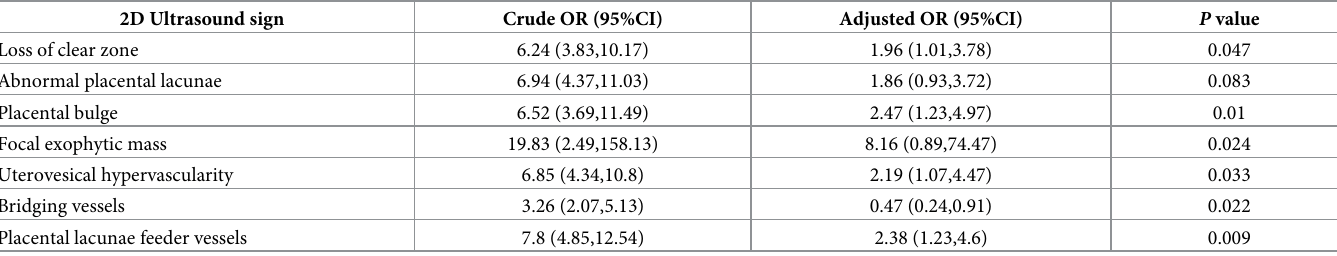
Table 4. Odds ratios of 2D ultrasound signs to predict massive PBL in the PAS group.